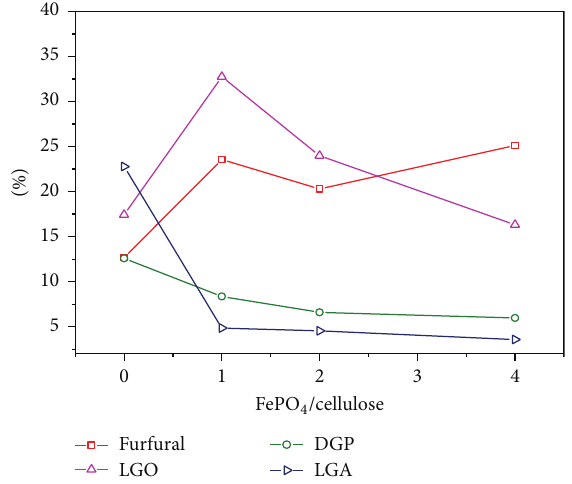
Figure 8: Influence of the mass ratio of FePO 4 to cellulose on the percentageof( ◻ )furfural,( △ )LGO,( I )DGP,and( Œ )LGAofbiooil produced from cellulose pyrolysis at 350 ∘